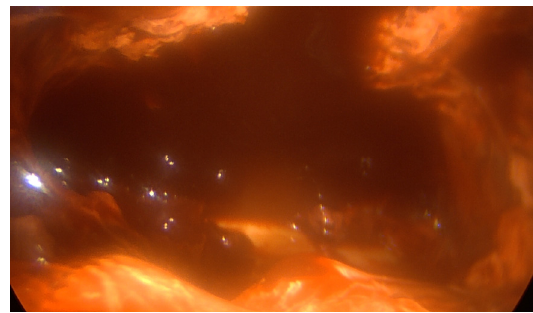
Figure 3. Intraoperative VATS view.